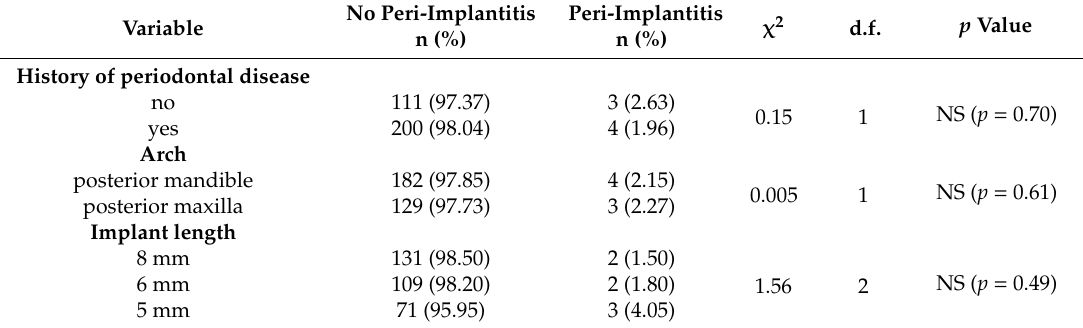
Table 7. Prevalence of peri-implantitis according to PP / NPP-groups, length-groups and arch-groups. For all variables, values are presented as n (%); NS = not statistically significant; d.f. = degrees of freedom.